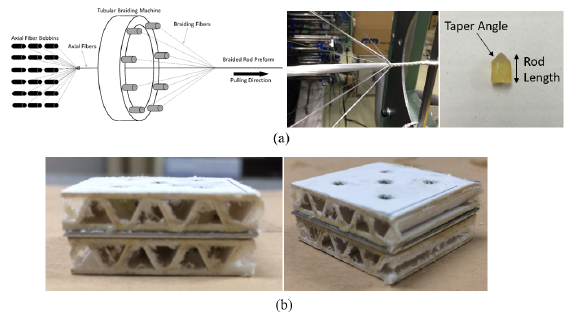
Figure 1: (a) Sketch and image of axial fiber bundles wrapped by braiding fiber bundles during the manufacturing process for fabri- cating rods, including a sample rod cut to length with a taper angle for compression testing; (b) Example of a sandwich structure pre- pared in this study consisting of corrugated cardboard, braided rods, and